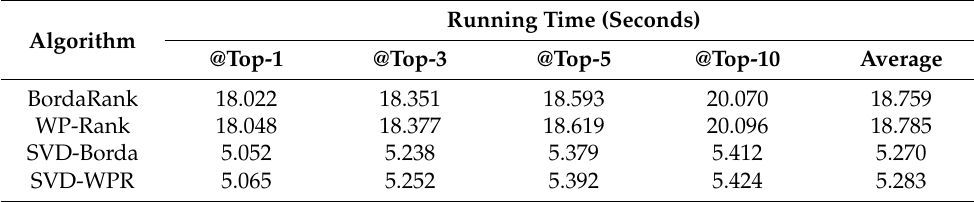
Table 7. Comparison of the average running time of the four ranking algorithms.